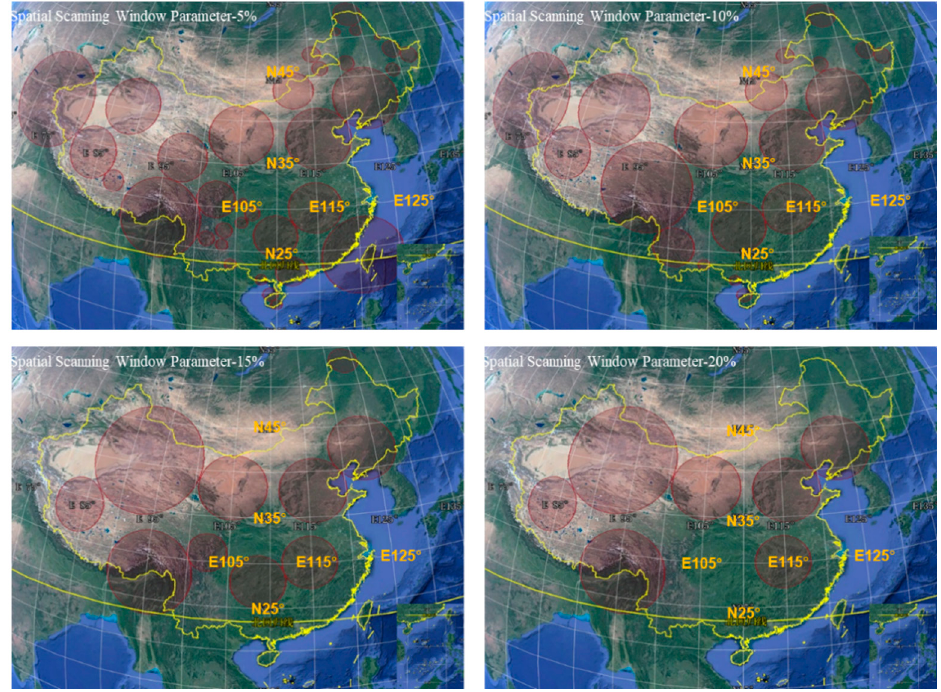
Figure 3. The results for scanning window thresholds set to 5%, 10%, 15%, and 20%. Table 1. Spatio–temporal scan results of China from 1 to 31 July, 2016 (15%).